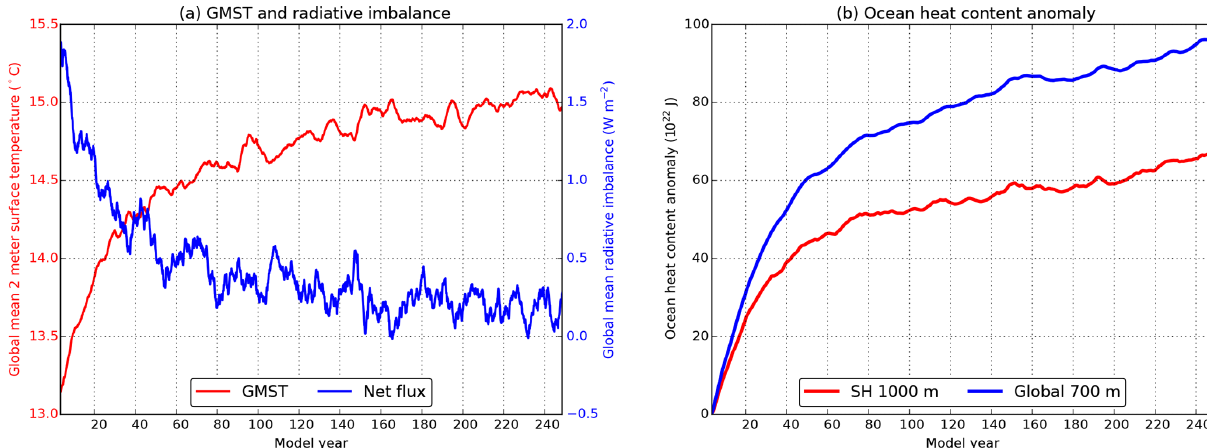
Figure 1. Equilibration of the CESM simulation for (a) the global mean 2m surface temperature (GMST) and global radiative imbalance at the top of the model (net flux) and in (b) the upper 700m global ocean heat content (OHC) anomaly and the upper 1000m Southern Hemisphere OHC anomaly. The anomalies are with respect to their initial value of model year 1. All time series are smoothed by a 60-month running mean.